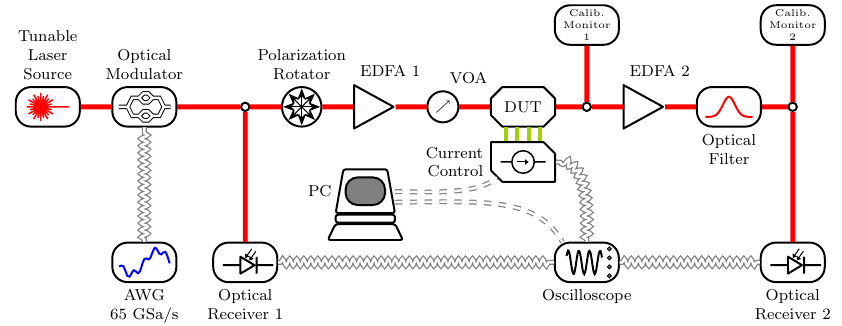
Figure 9. Experimental setup. The different components are labeled in the figure and explained in the text. The complex perceptron is indicated as the DUT (Device Under Test). Red lines refer to optical signals, black lines to electrical